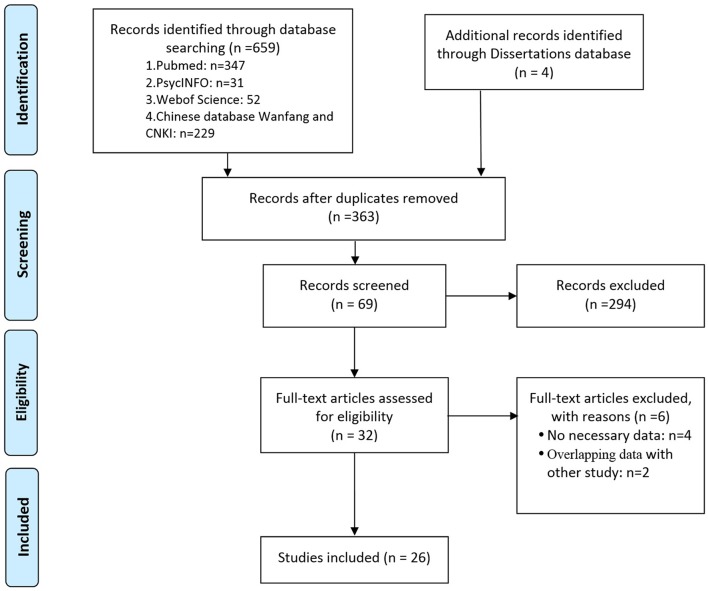
Preferred Reporting Items for Systematic Reviews and Meta-analyses (PRISMA) flow diagram illustrating the systematic literature search.